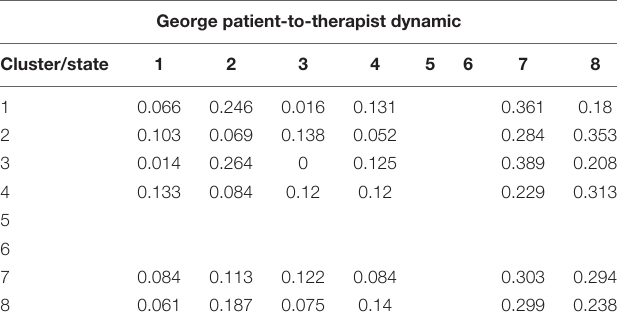
TABLE 4 | George’s patient-to-therapist symbolic